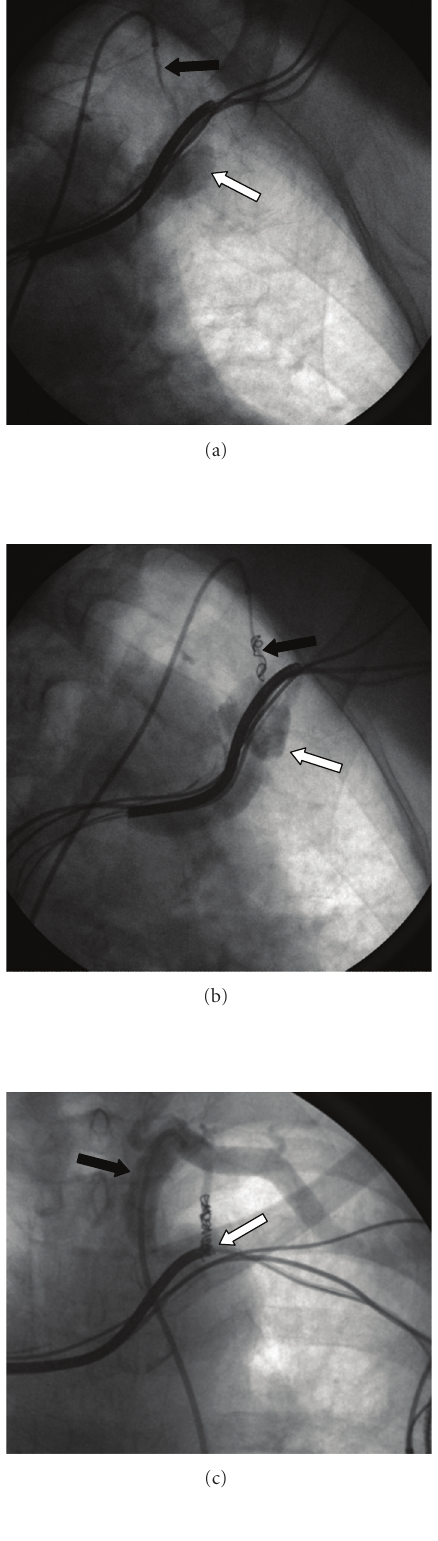
Figure 2: Case 2 arteriograms of the LIMA fistula with the proximal subclavian vein. Initial angiogram (a), during coil deployment (b), and final angiogram (c) showing successful closure of the AVF. (white arrows, subclavian/brachiocephalic venous system; black arrows, subclavian artery and